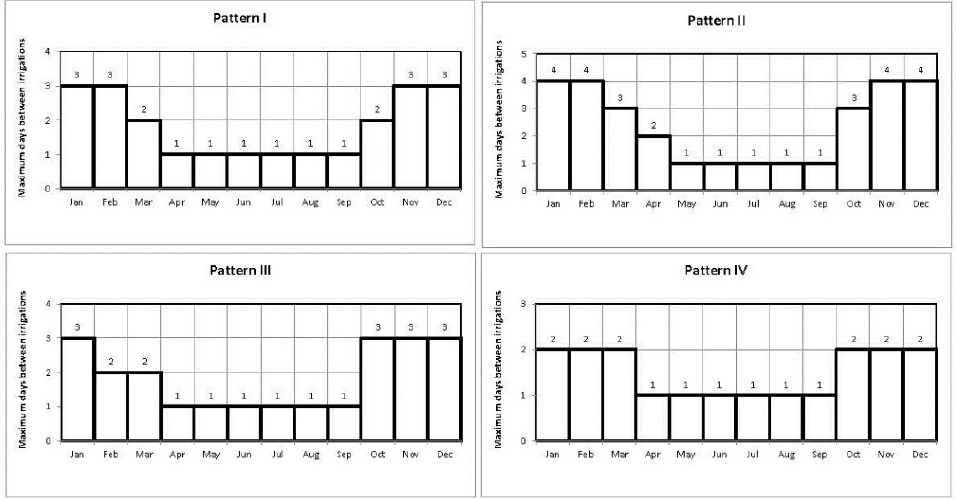
Figure 10. Patterns of maximum days between irrigations.